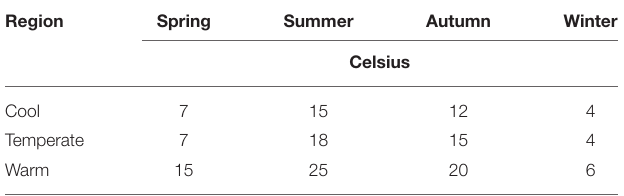
TABLE 4 | Overview over the category of publications from where data has been used in this